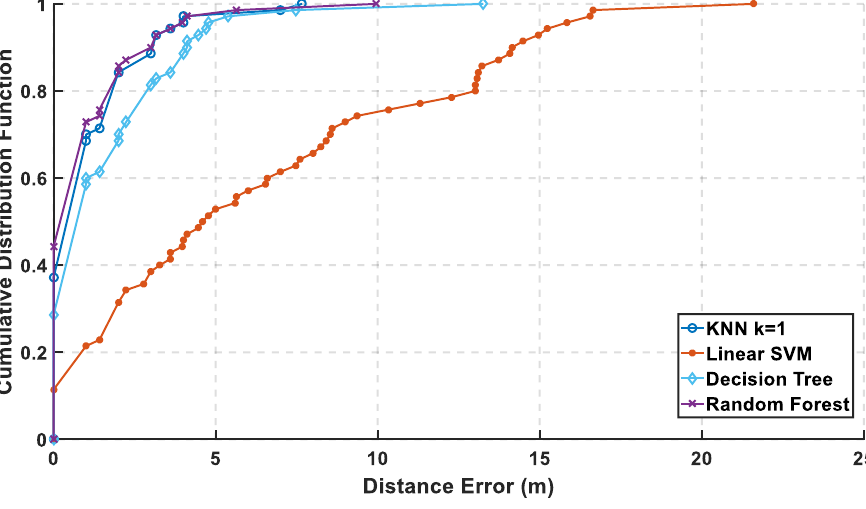
Figure 14. CDF Error with PCA with 18th PCs. Table 1. The CDF Error within 3 m.